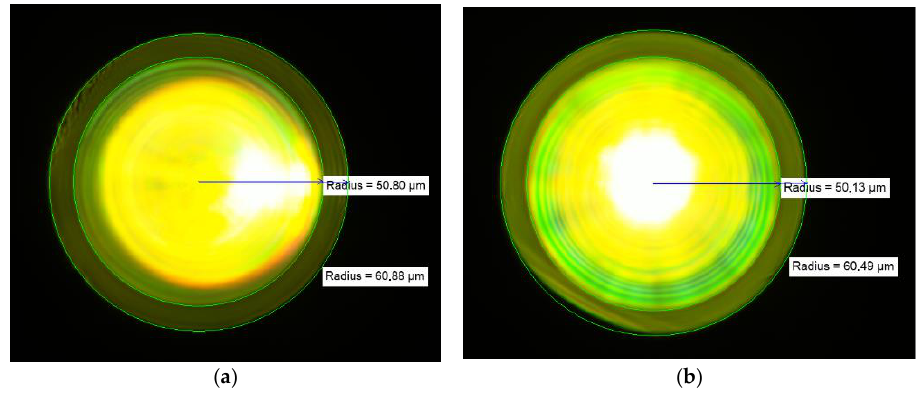
Figure 6. LOMF 100/125 end (CCDR measurement): ( a ) beginning of the drawn length; ( b ) end point.